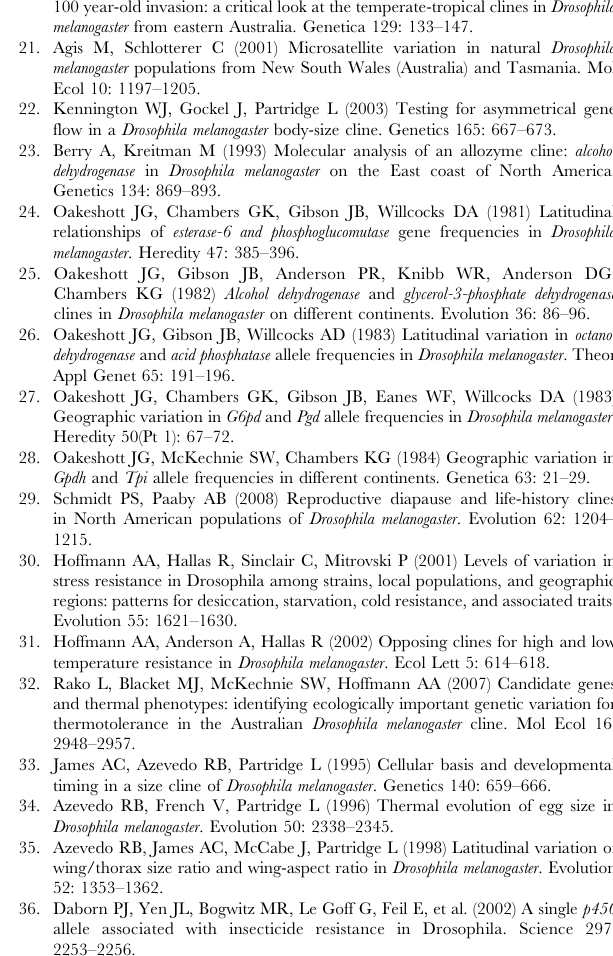
Table S2 Selection coefficient estimates.